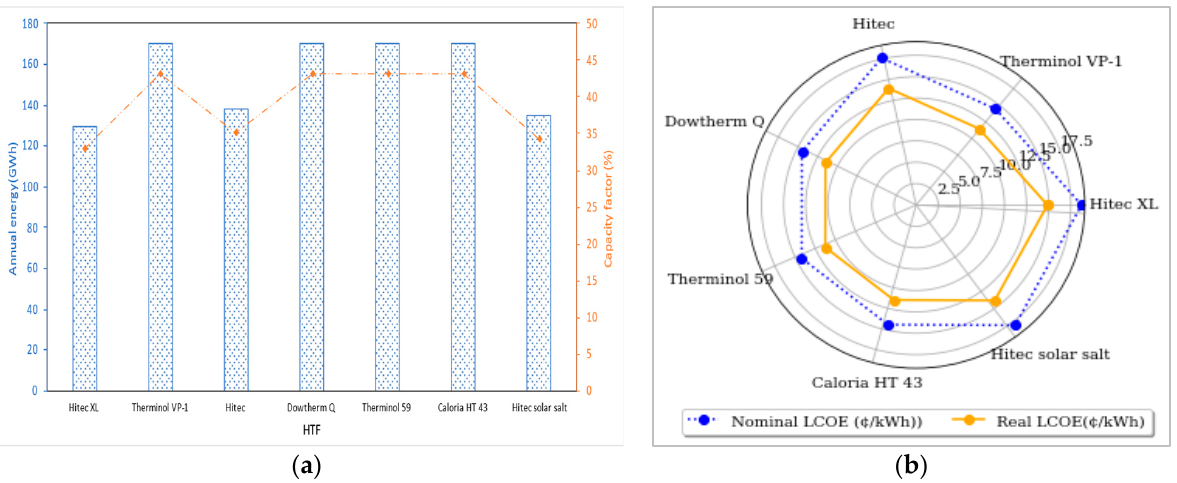
Figure 6. Comparison of ( a ) output power and capacity factor and ( b ) nominal and real LCOE for PTC plant with different types of HTFs.